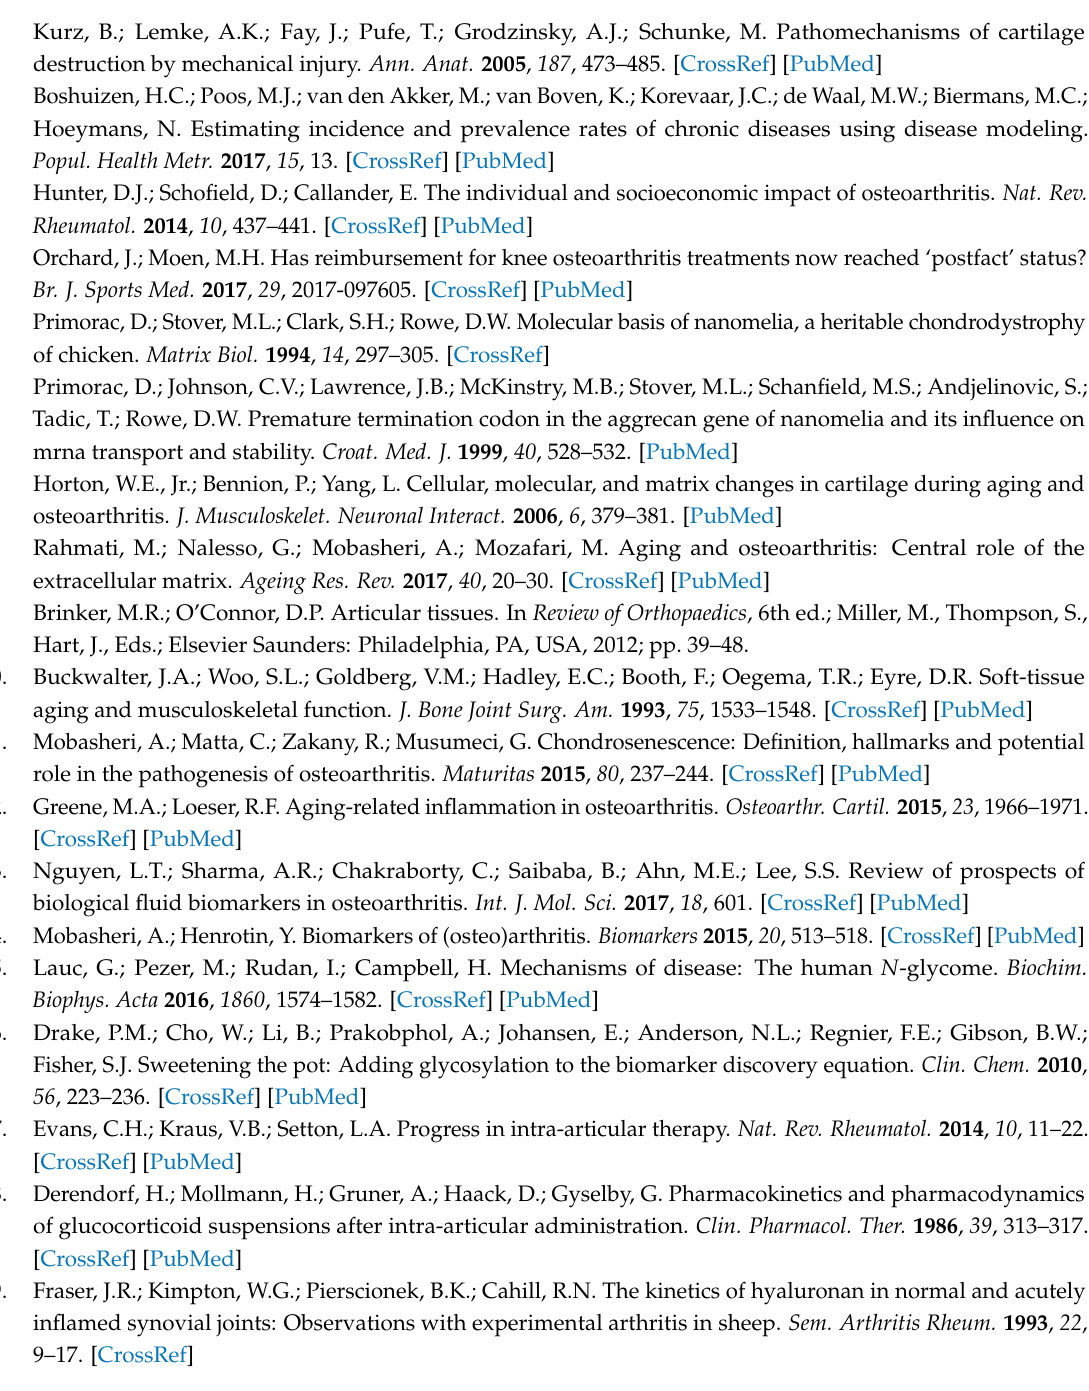
patient dG17; Figure S15: The scheme of the dGEMRIC index with different joint facets throughout the study period at T0, T3, T6 and T12 combined with VAS scale ratings in T0, T3, T6, T12 for patient